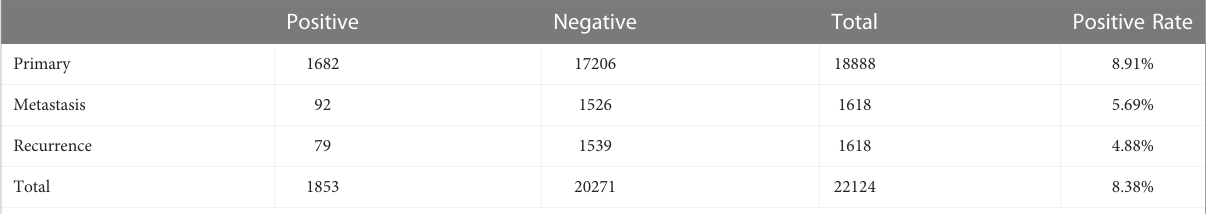
TABLE 1 LPAR5 + macrophages among primary, metastasis and recurrent osteosarcoma patients. Positive Negative Total Positive